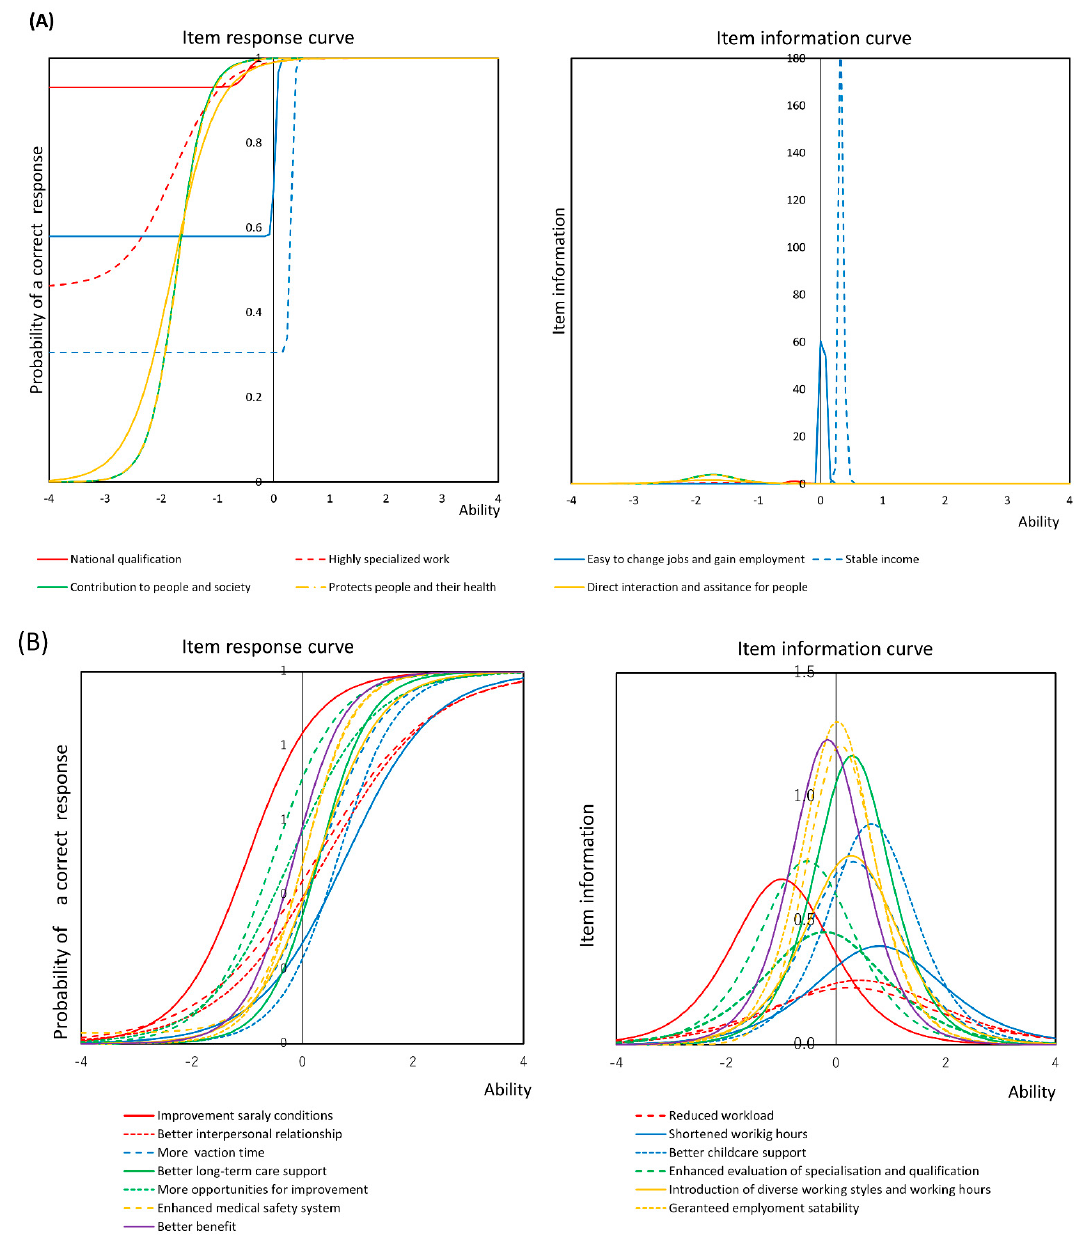
Figure 2. Item response curve and item information curve for the items regarding job attractiveness of dental hygienists’ work and the factors dental hygienists feel would improve the work environment. ( A ) Job attractiveness ( B ) The factors dental hygienists feel would improve the work environment.